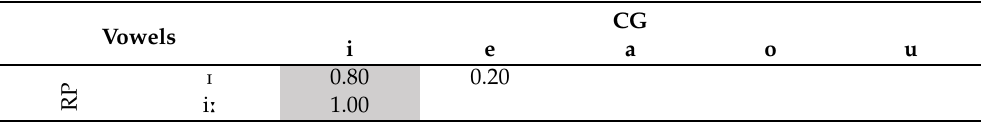
Table 3. Classification results of the LDA analysis for English vowels / I / and /i : /. Dark gray cells represent the L1 responses with the highest